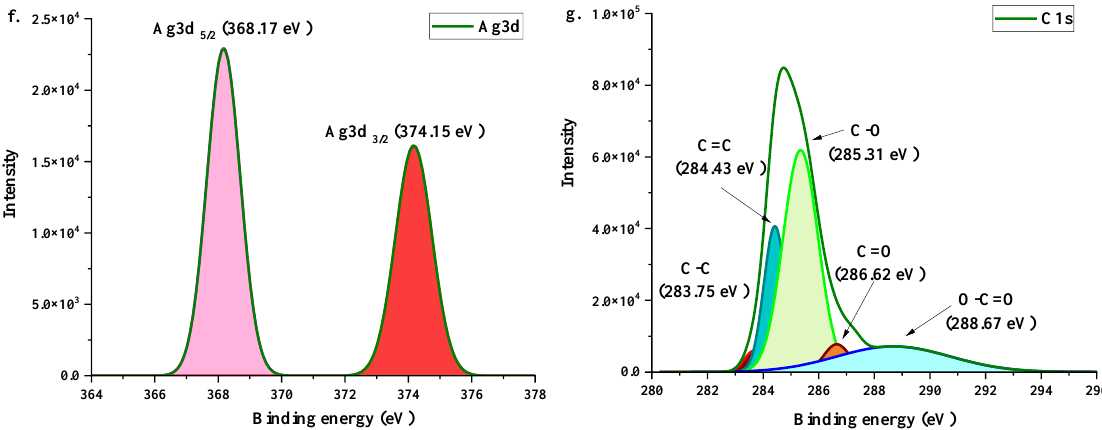
Figure 3. XPS spectra of AgZnS-G-T photocatalyst: ( a ) full survey; ( b ) O1s; ( c ) S2p; ( d ) Ti2p; ( e ) Zn2p; ( f ) Ag3d; ( g ) C1s.